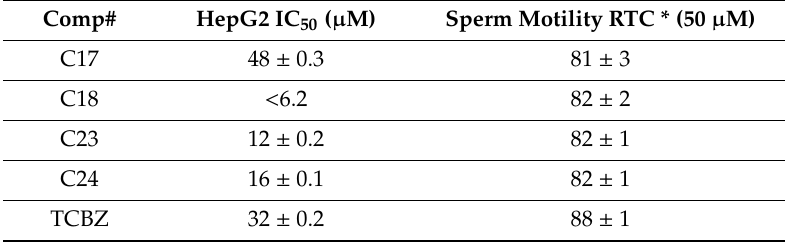
Table 3. Cytotoxicity assays in the human cell line HepG2 and bovine spermatozoa. For the HepG2 cell line, the IC 50 was calculated for each compound. In bovine spermatozoa, compounds were tested at a fixed dose of 50 µ M. Sperm motility was calculated relative to that of the control sperm (incubated with the vehicle). We included the drug of reference, triclabendazole, to test its cytotoxicity with both cell